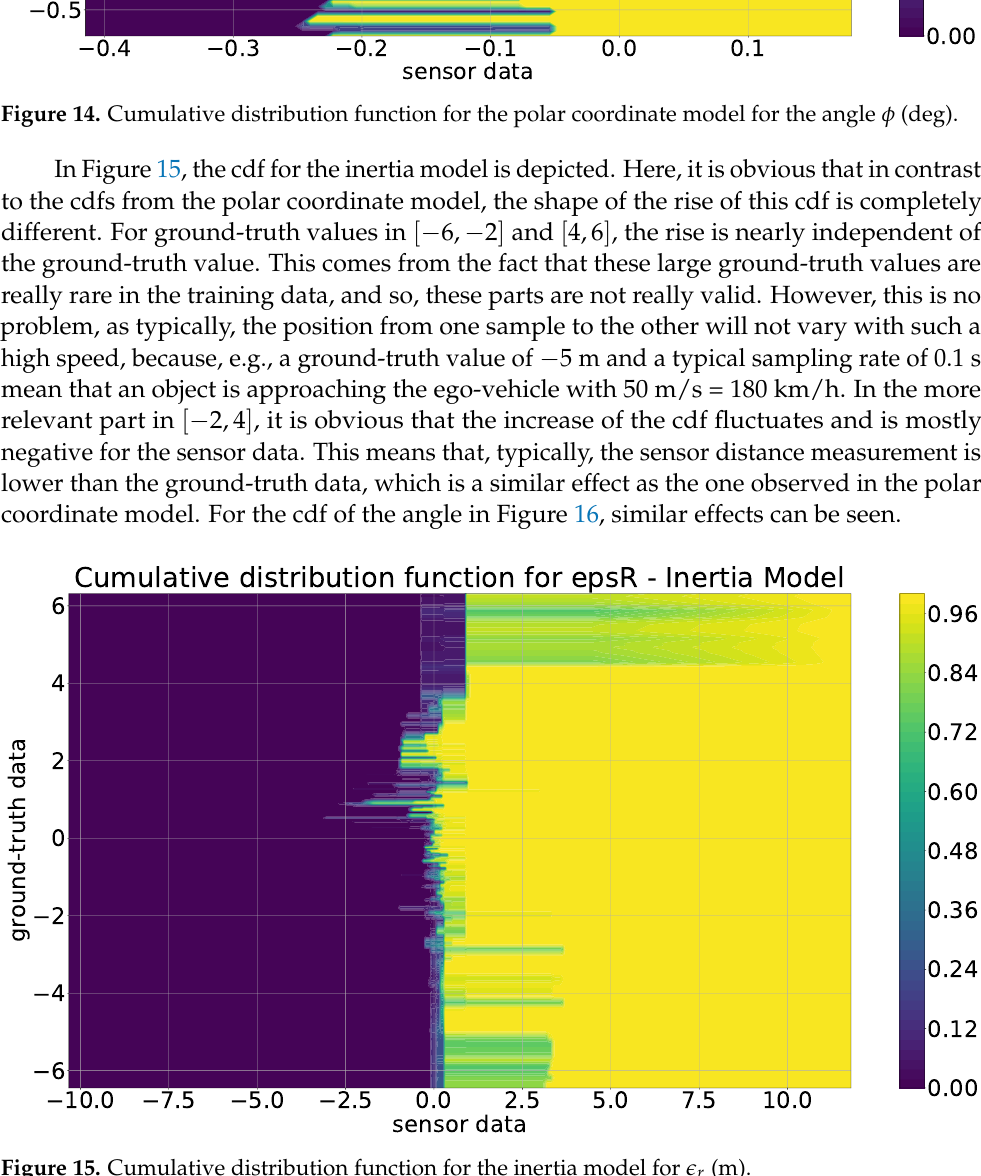
Figure 15. Cumulative distribution function for the inertia model for (cid:101) r